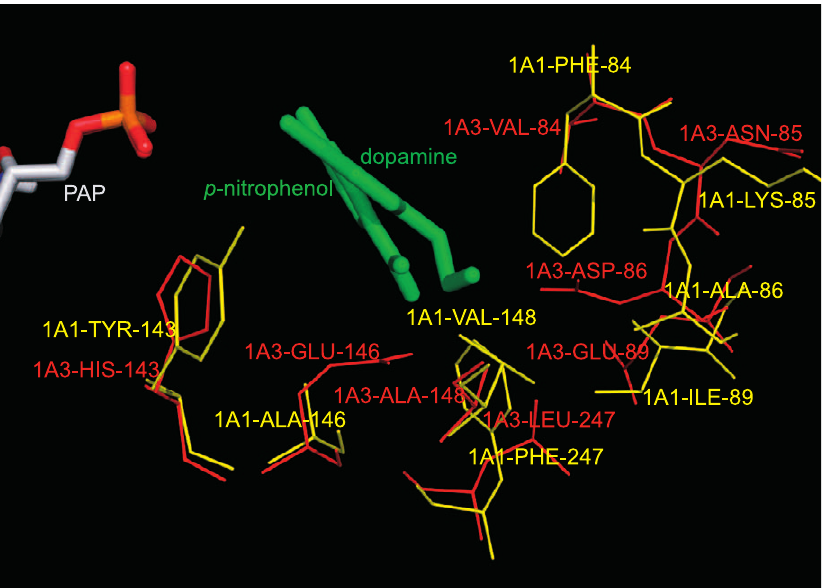
Figure 9. Binding Site Comparison of SULT1A1 Bound to PAP and p -Nitrophenol (1LS6) and SULT1A3 Bound to PAP and Dopamine (2A3R) The side chains of the eight binding-site residues that differ between these two proteins are shown in yellow (SULT1A1) and red (SULT1A3).